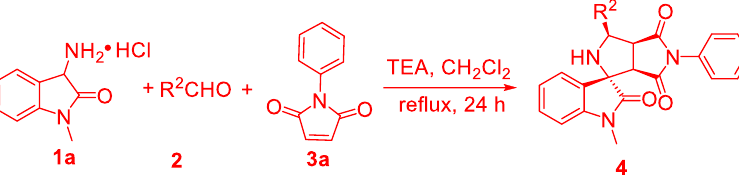
Table 2. Scope of aldehyde 2 a .